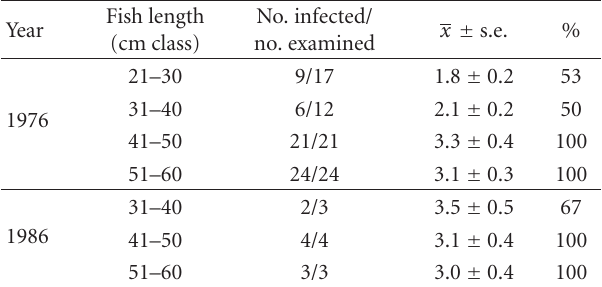
Table 1: Abundance ( x ± s.e.) and prevalence (%) of the copepod, Lernaeocera branchialis , on the gills of the rock cod, Gadus ogac , sampled in Labrador in 1976 and